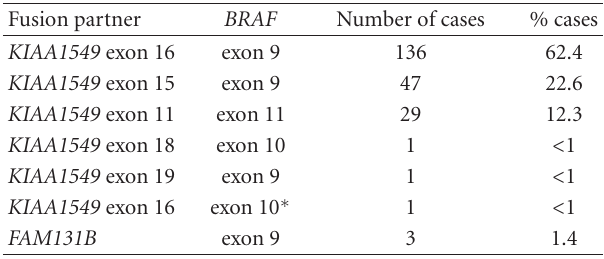
Table 1: Summary of reported BRAF fusion transcripts. Fusion partner BRAF Number of cases %